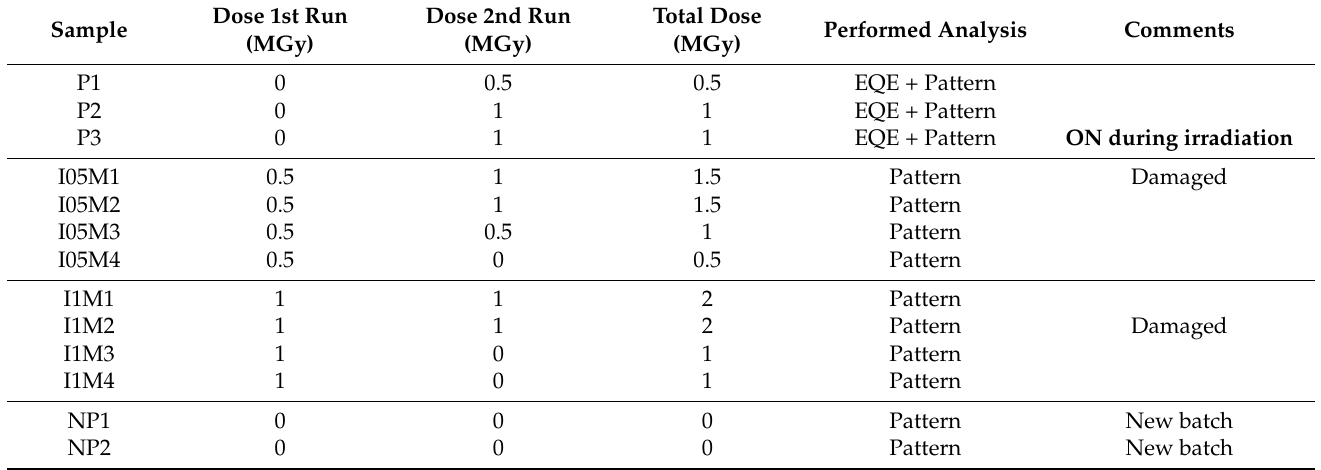
Table 1. List of the investigated samples and irradiation